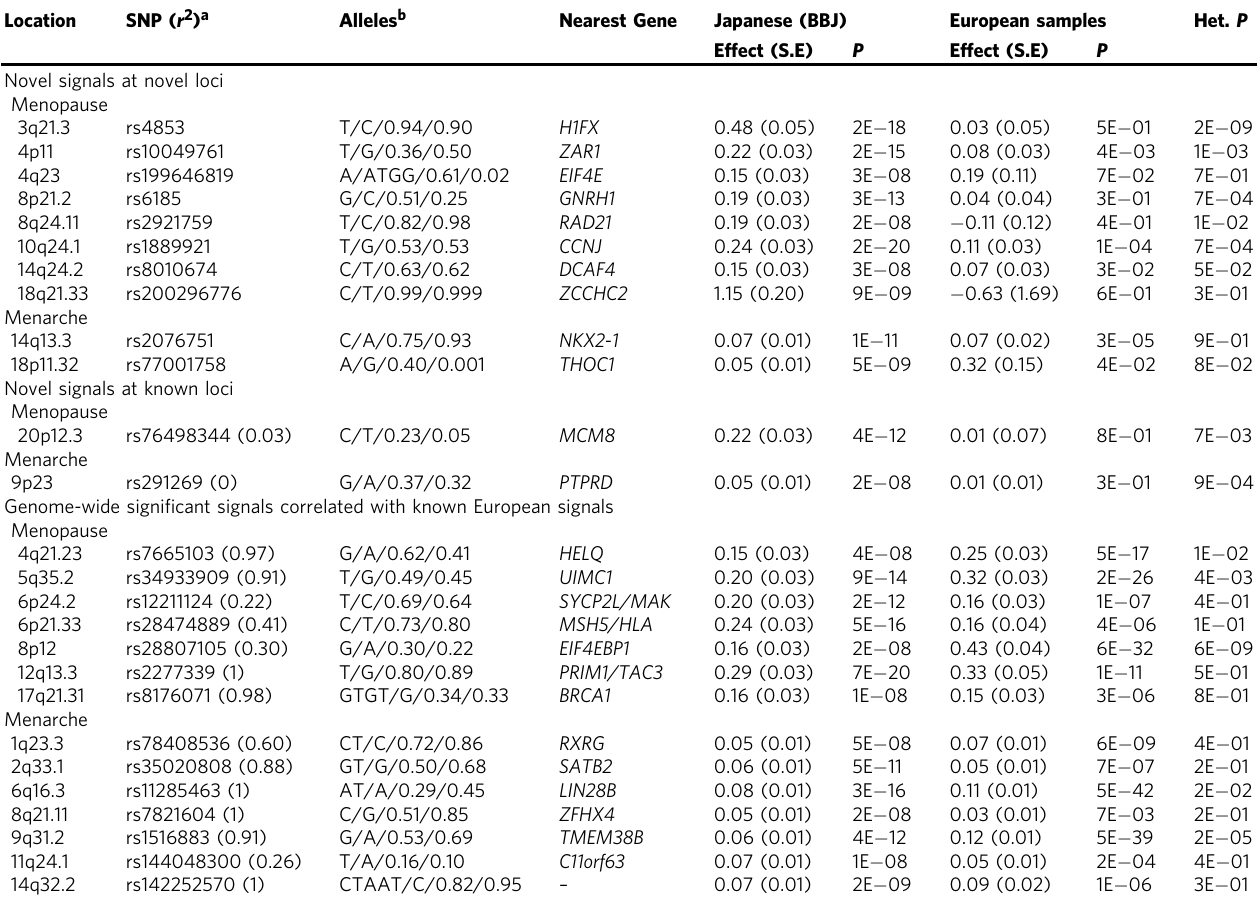
Table 1 Genome-wide signi fi cant signals identi fi ed for ages at menarche and menopause in the BioBank Japan Project